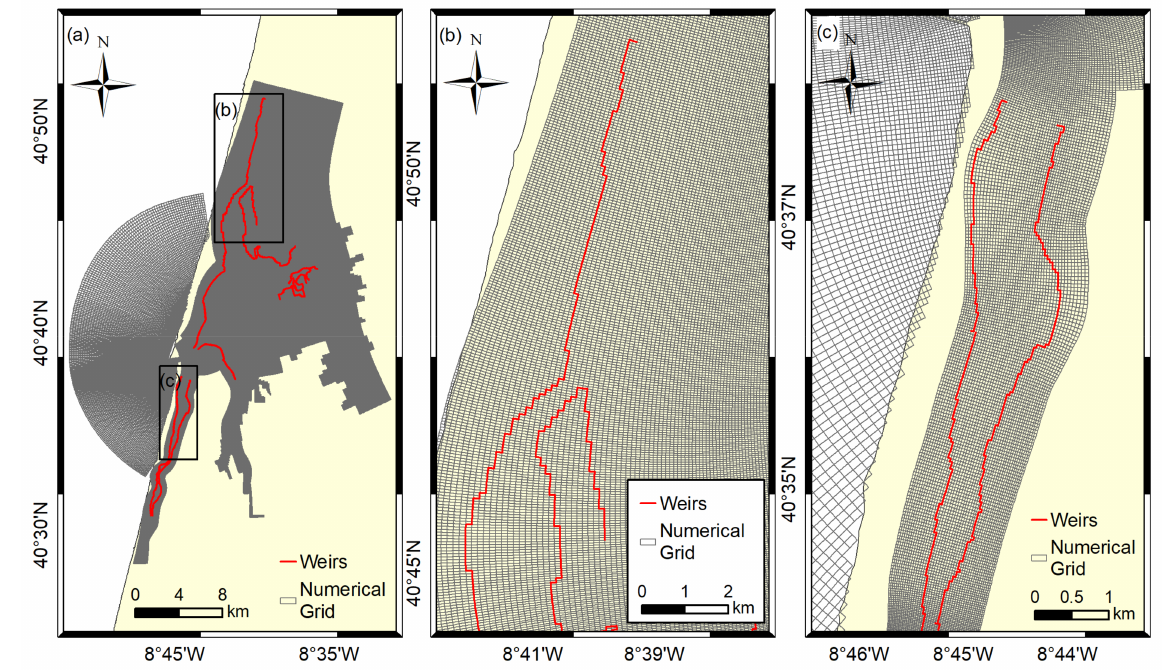
Figure 3. ( a ) Numerical model grid, including the location of local barriers (weirs, dams, dikes, etc.), ( b ) zoom on the S ã o Jacinto channel head and ( c ) zoom on the Mira